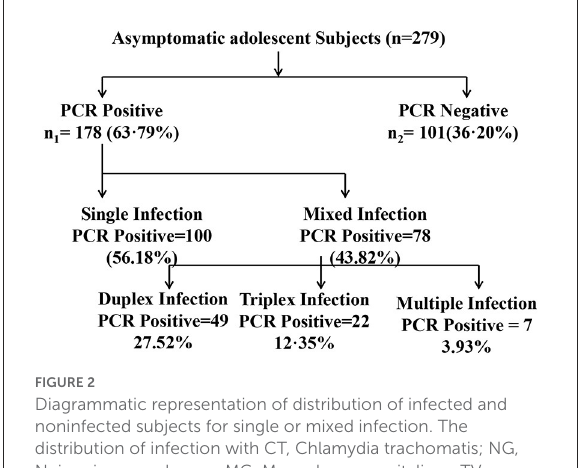
FIGURE2 Diagrammatic representation of distribution of infected and noninfected subjects for single or mixed infection. The distribution of infection with CT, Chlamydia trachomatis; NG, Neisseria gonorrhoeae; MG, Mycoplasma genitalium; TV, Trichomonas vaginalis; MH, Mycoplasma hominis; UU, Ureaplasma urealyticum; UP, Ureaplasma parvum out of the total asymptomatic adolescent subjects enrolled in the study is